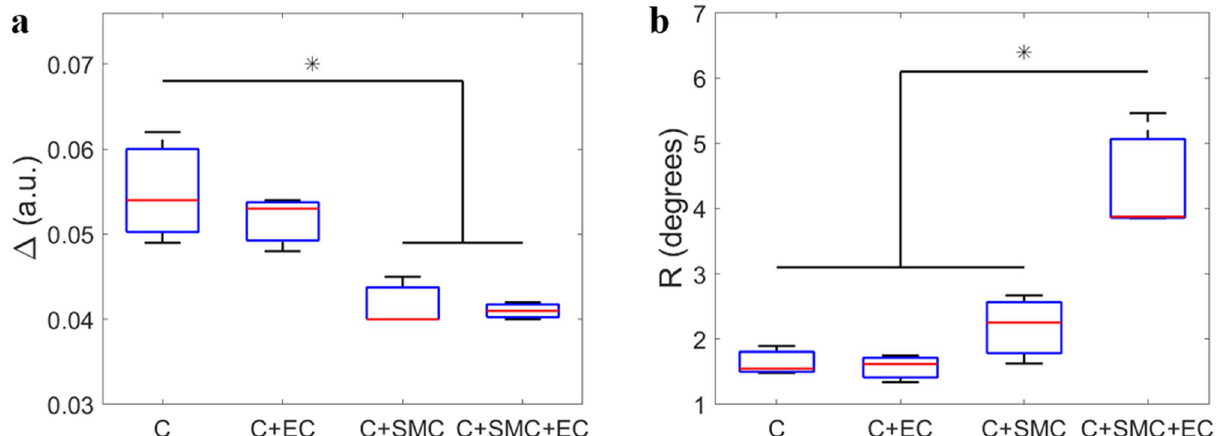
Figure 4. ( a ) Depolarization and ( b ) retardance for collagen hydrogel alone (C), collagen hydrogel with ECs on its top surface (E + EC), collagen hydrogel with embedded SMCs (C + SMC), and collagen hydrogel with embedded SMCs and ECs on its top surface. The mean value of each polarimetric parameter per sample was calculated for all pixels contained in the area shown by yellow rectangle in Fig. 3a. The red lines in the box plots denote the median values among samples means, whereas the whiskers extend to the most extreme data points. * p < 0.050. Three independent samples were analyzed for each